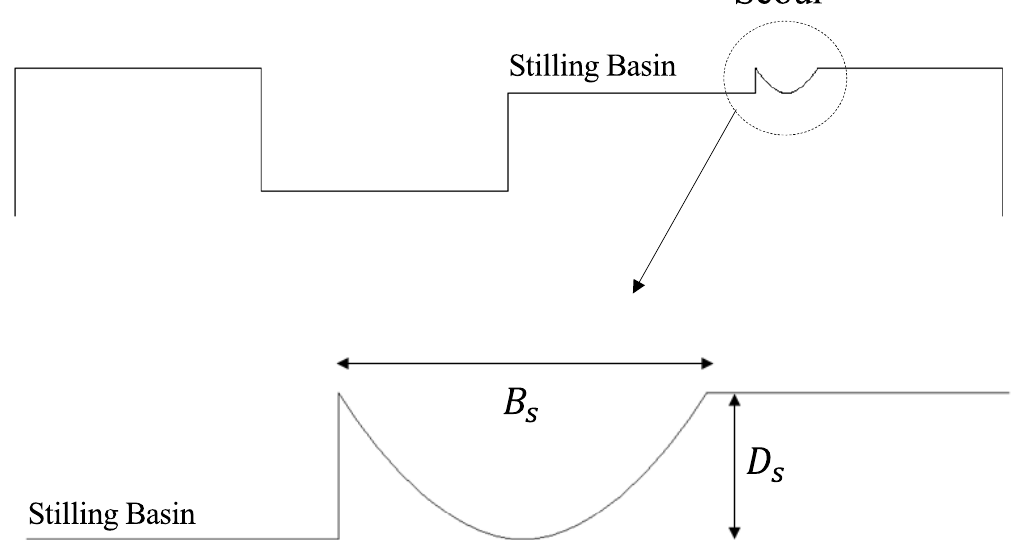
Fig. 7 . Dimensions of the scour at the toe of the stilling basin.